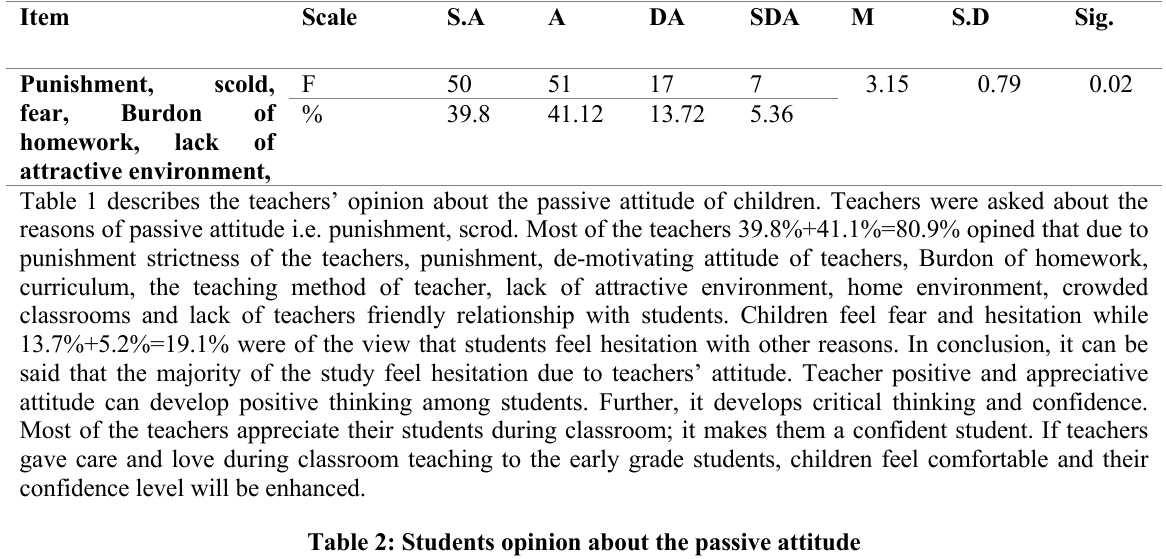
Table 2: Students opinion about the passive attitude